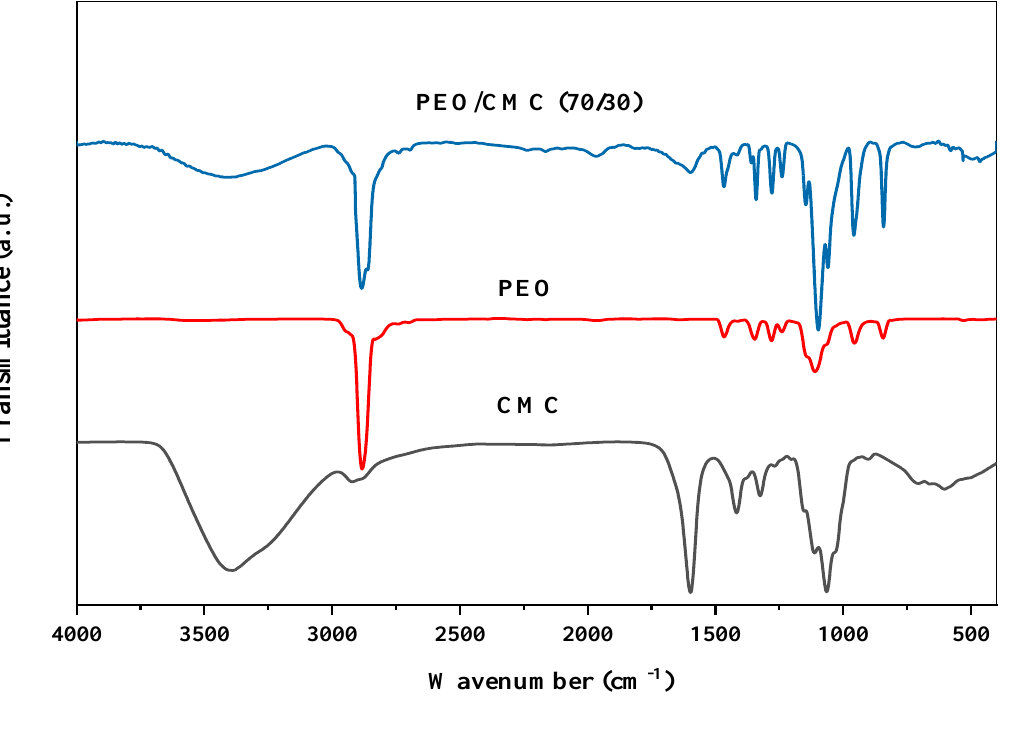
Figure 2. FTIR spectra of pure PEO, CMC, and the pure (PEO/CMC) blend.